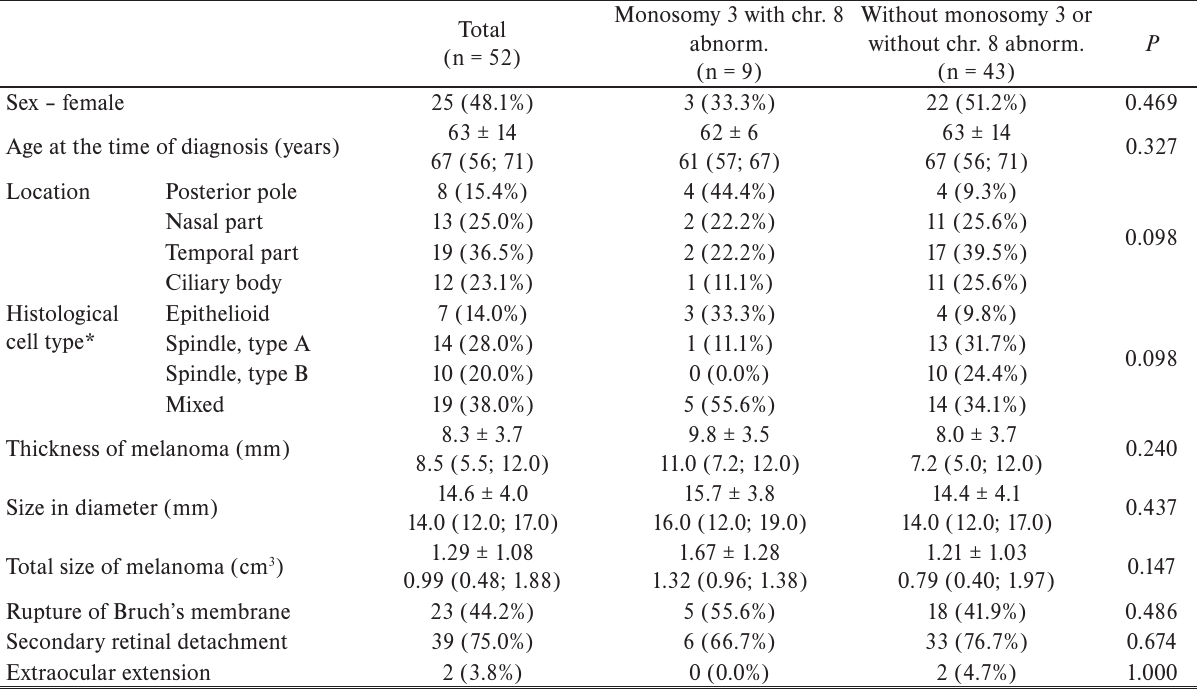
Table 4. Baseline characteristics of patients by abnormalities of chromosome 3 and 8. Monosomy 3 with chr. 8 Total (n = 52)